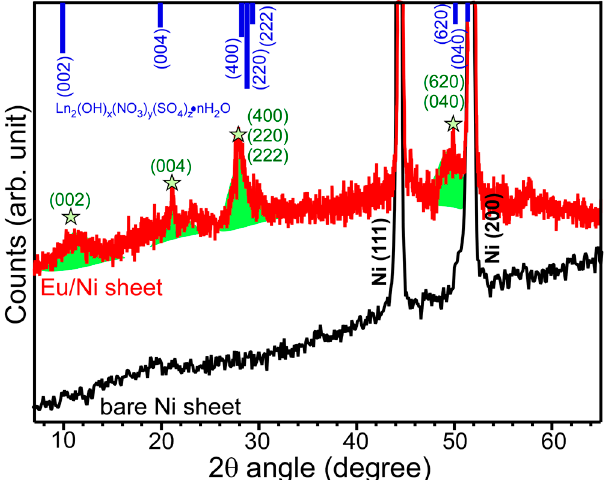
Figure 5. XRD data for bare Ni and selected electrodeposited Eu on a Ni sheet. The literature XRD patterns for Ln 2 (OH) x (NO 3 ) y (SO 4 ) z ·nH 2 O complex are shown for comparison. patterns for Ln 2 (OH) x (NO 3 ) y (SO 4 ) z · nH 2 O complex are shown for